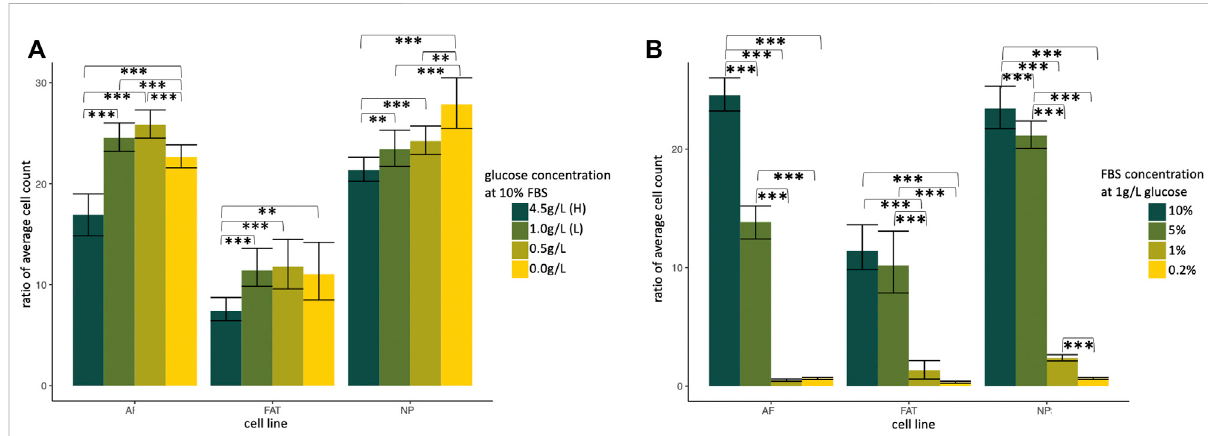
FIGURE 3 Normalized ratio of average cell count indicating cell proliferation of primary cells isolated from annulus fi brosus (AF), nucleus pulposus (NP), and subcutaneous adipose tissue (FAT). Cells were cultured in supplemented DMEM and subjected to a glucose (A) and growth factor (B) challenge. H, high; L, low; FBS, fetal bovine serum. Cells were isolated from two different donors and plated as three technical replicates for each cell line and